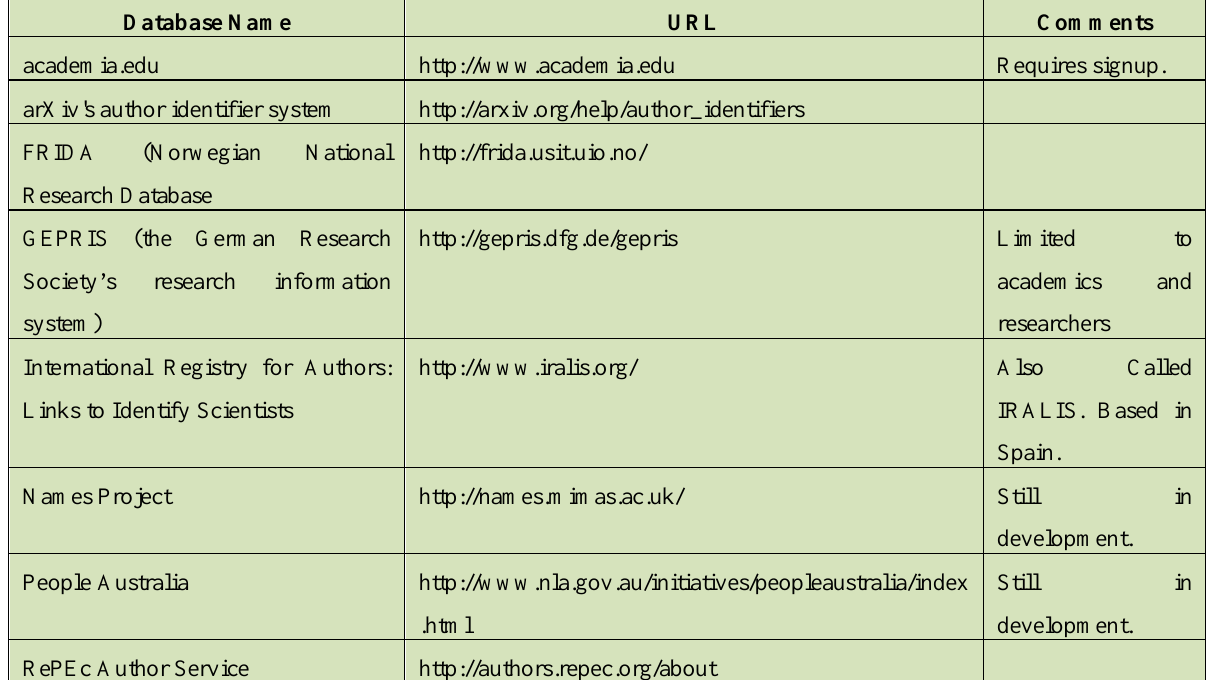
Table 2. Other systems and databases that help with name